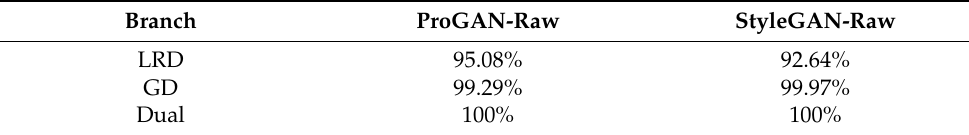
Table 5. The ablation study in two branches (Test criteria adopt accuracy (%)).